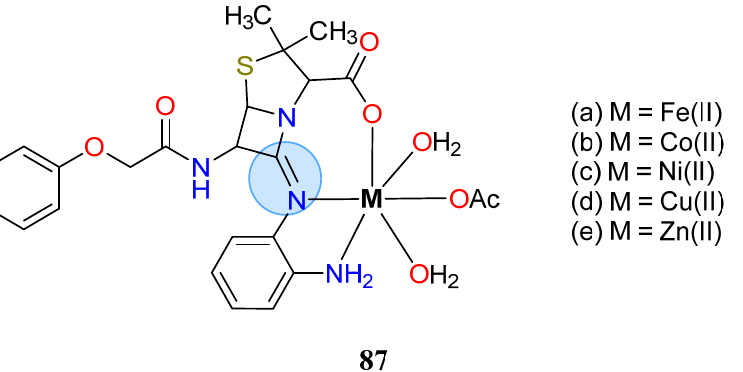
Figure 44. Metal complexes containing a tridentate SB ligand (NNO) based on phenoxymethylpenicillin studied for their antibacterial activity.